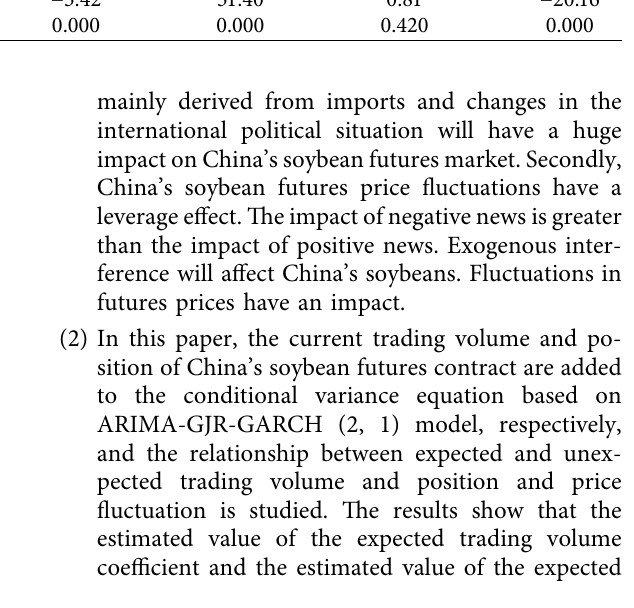
Table 6: The relationship between trading volume and China’s soybean futures price volatility. Coefficient estimation Untraded model Traded model Table 7: The relationship between open position holding and price fluctuation of China’s soybean futures market. Coefficient estimation Untraded model Coefficient estimation Traded model